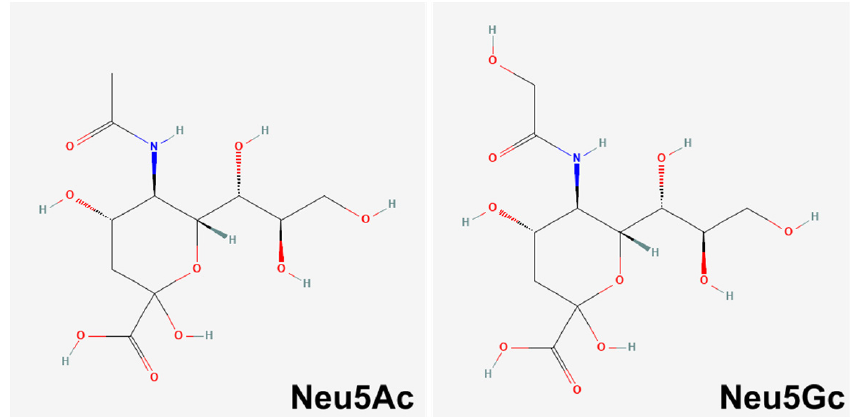
Figure 1. Chemical structure of Neu5Ac and Neu5Gc. Neu5Gc differs by a single oxygen atom that is added by the CMAH enzyme. Retrieved from PubChem [18] (Neu5Ac–CID 439197; Neu5Gc–CID 440001).